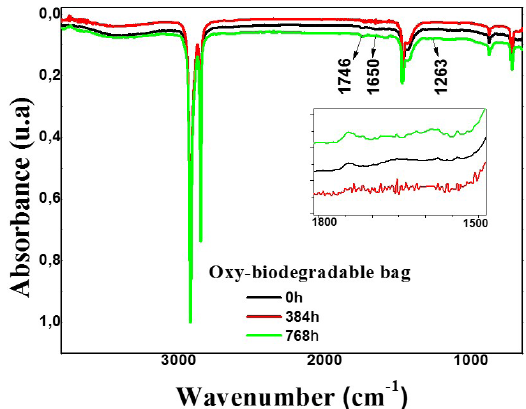
Figure 8. Oxy-biodegradable bag under exposure